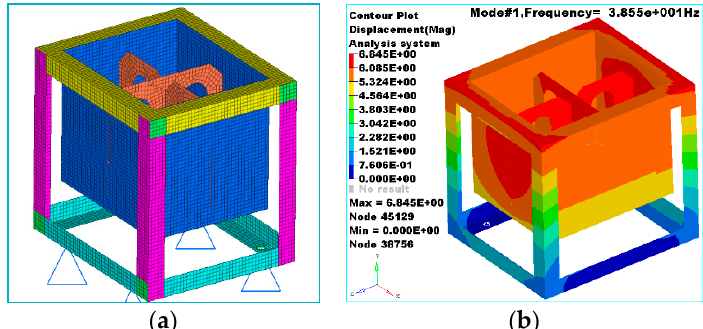
Figure 3. ( a ) Finite element model of the fuel-tank structure and ( b ) simulation results at 1/4 of full fuel level.